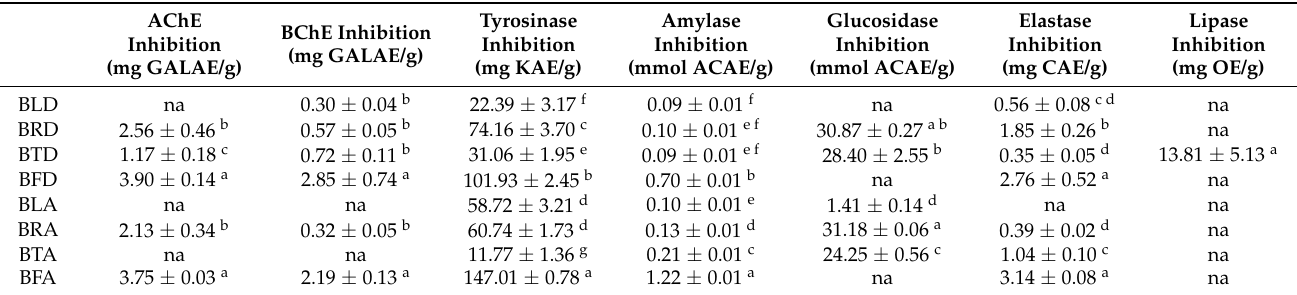
Table 7. Enzyme inhibitory effects of B. gymnorhiza